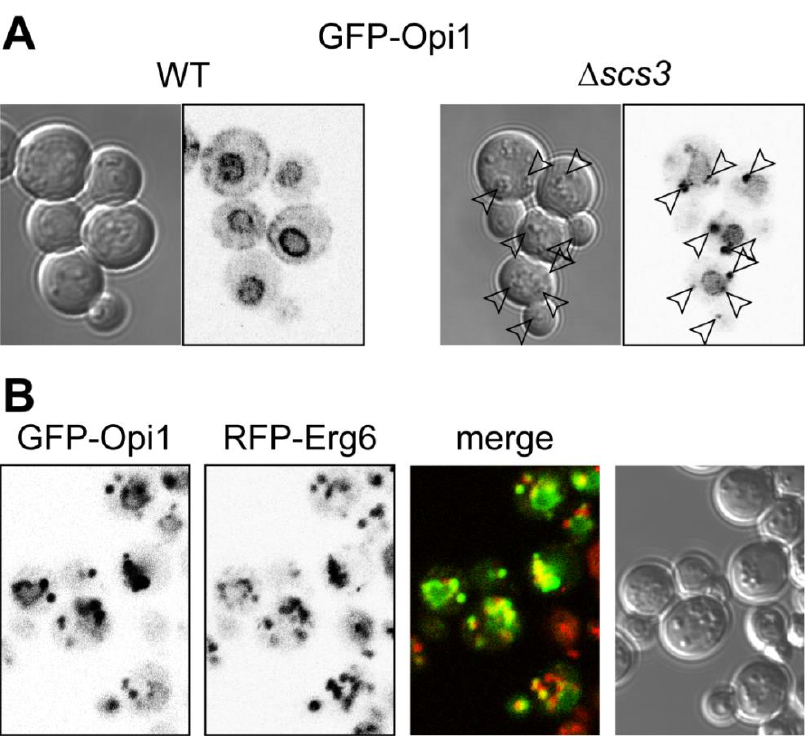
FIGURE 1: GFP-Opi1p re-localises to lipid droplets in cells lacking Scs3p . (A) GFP- Opi1p was expressed in wild-type cells (left) and scs3 ∆ cells (right) that were grown without inositol. In wild-type cells, GFP-Opi1p localises most prominently to the nuclear envelope, and also to the cortical ER that forms patches adjacent to the cell periphery [30]. In scs3 ∆ cells, GFP- Opi1p is only faintly on the nuclear enve- lope, and mostly in puncta. Arrowheads indicate these puncta and the correspond- ing positions in the accompanying trans- mission image. (B) scs3 ∆ cells expressing GFP-Opi1p as in A (1 st panel), and co- expressing RFP-Erg6p, a lipid droplet marker (2 nd panel), with pseudo-coloured green and red merge (panel 3, superposi- tion = yellow) and transmission image (panel